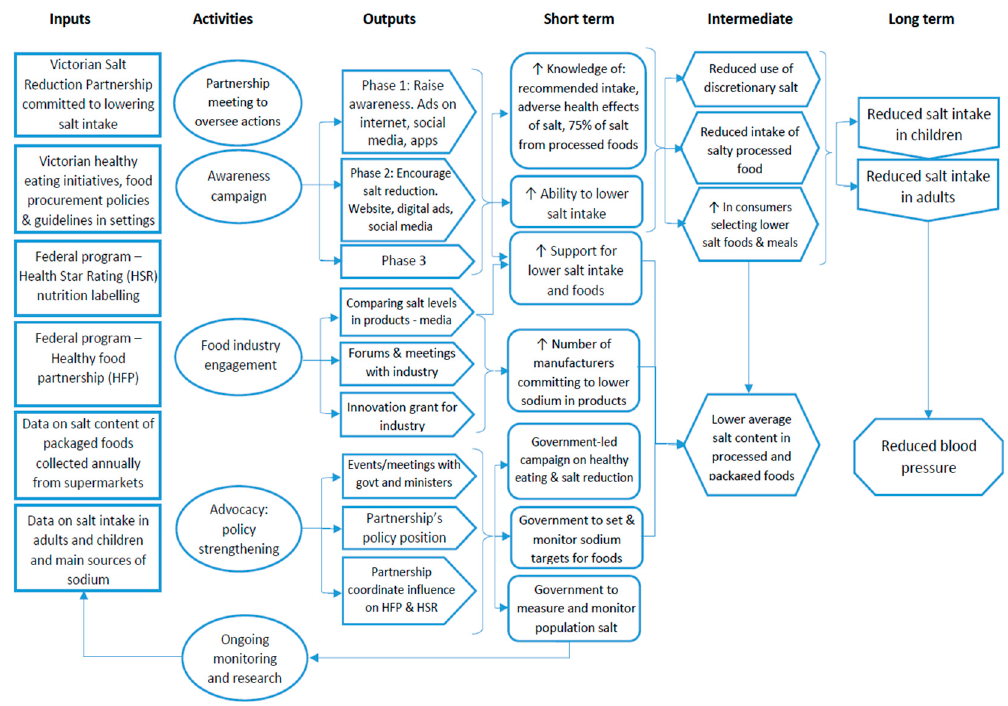
Figure 1. Logic model of the VicSalt Partnership program of interventions. Source: Trieu et al. 2018 [14].